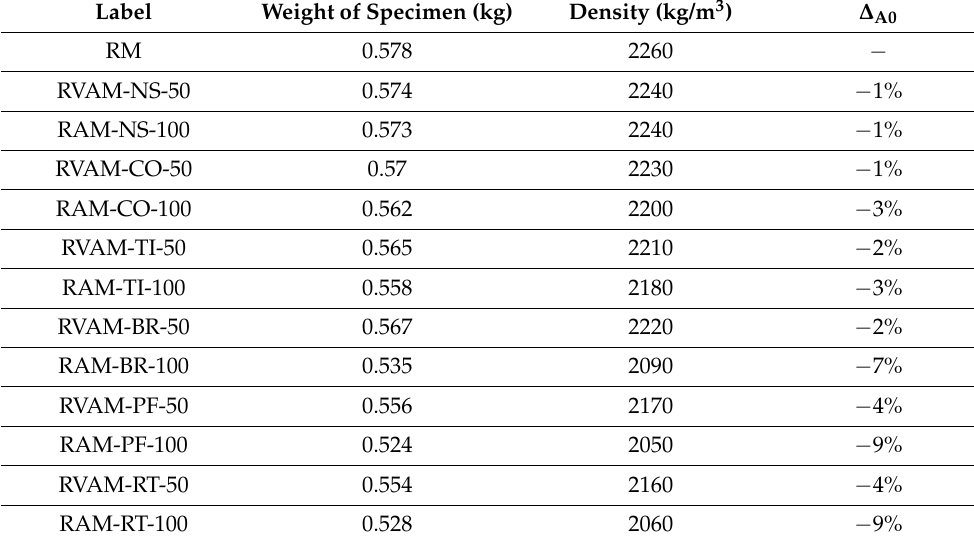
Table 4. Physical properties of